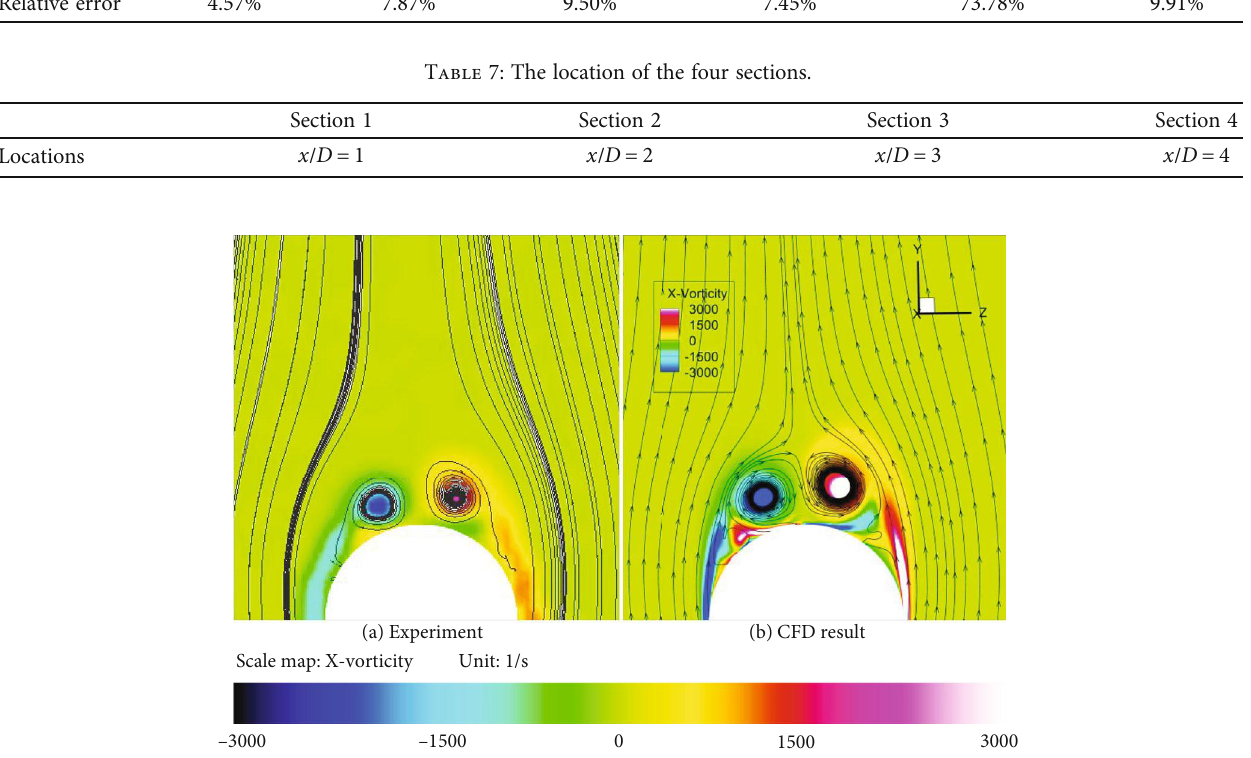
Figure 15: Comparison contour of experimental and numerical simulation results for surface roughness R a = 0 : 8 μ m at section 1.